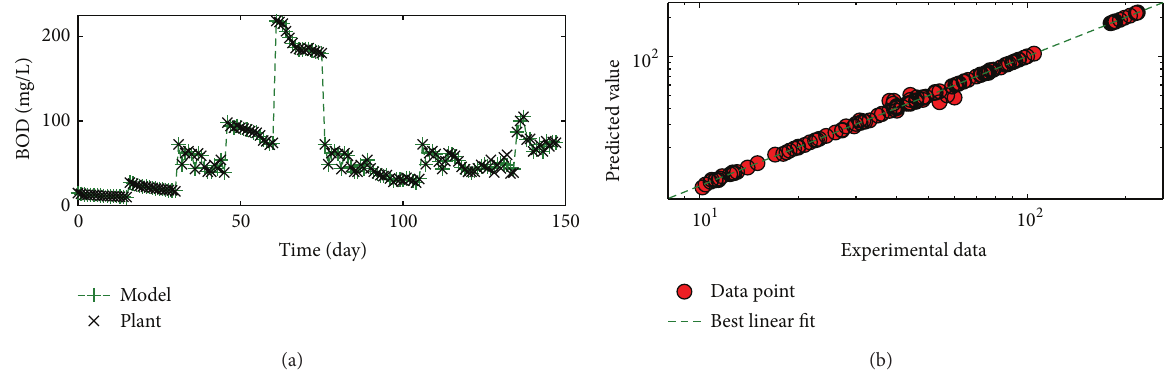
Figure 5: The responses of the developed model (a). Correlation between the actual values and the values predicted by the model for BOD (b).